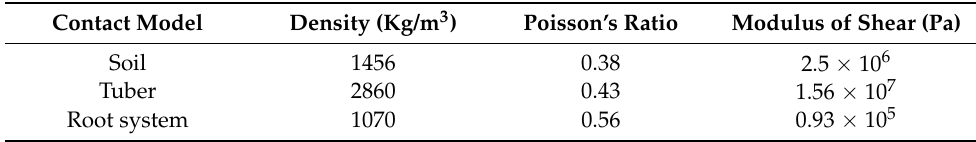
Table 3. Physical parameters of Cyperus esculentus